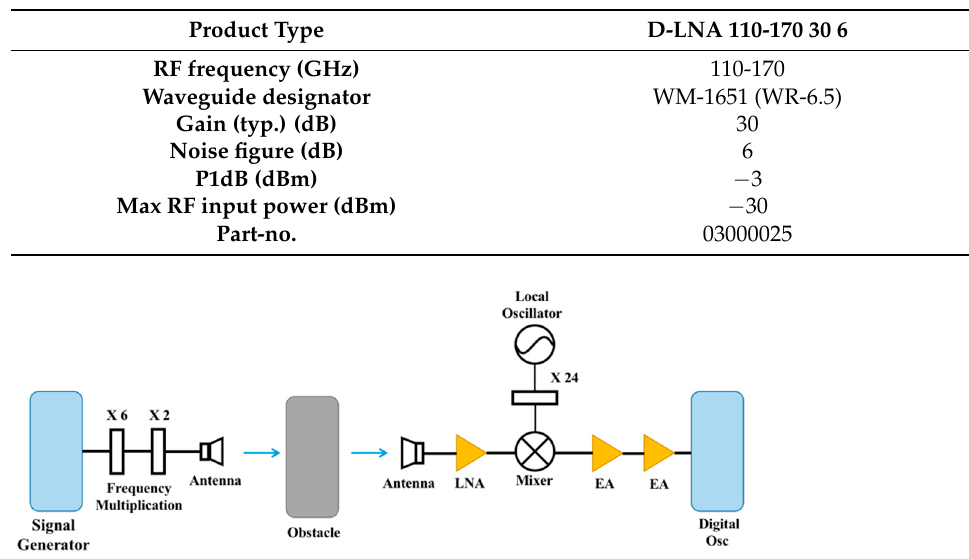
Table 2. The parameters of LNA.